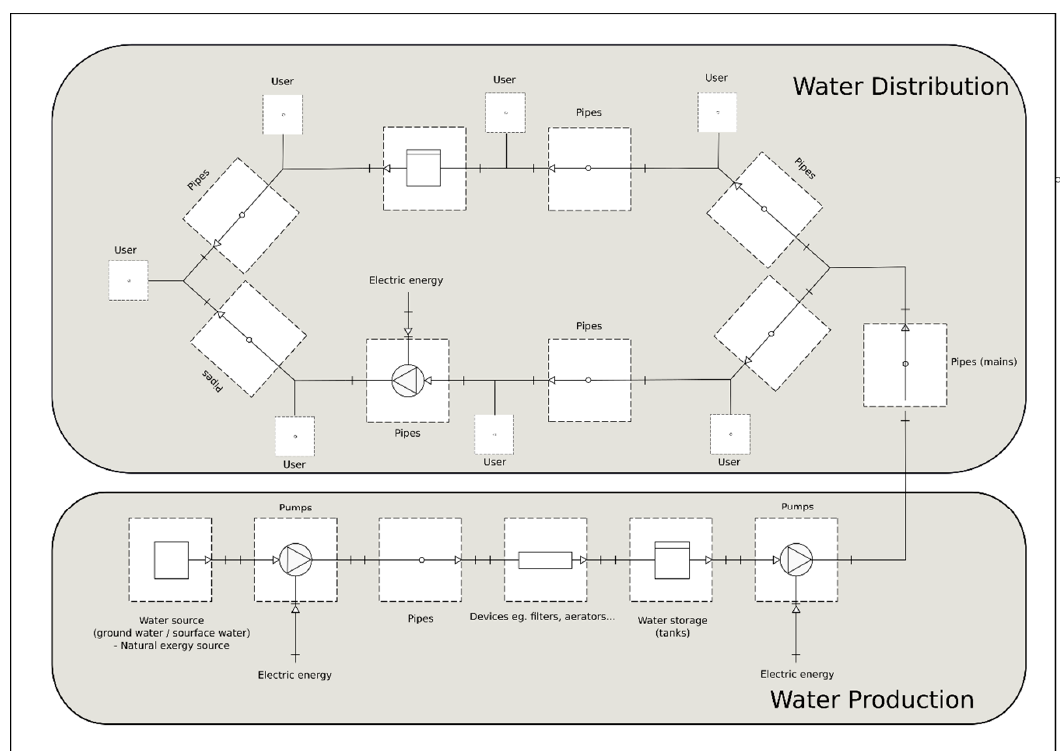
Figure 1. Scheme of a water supply system. Table 1. Source of exergy destructions in a water distribution system.